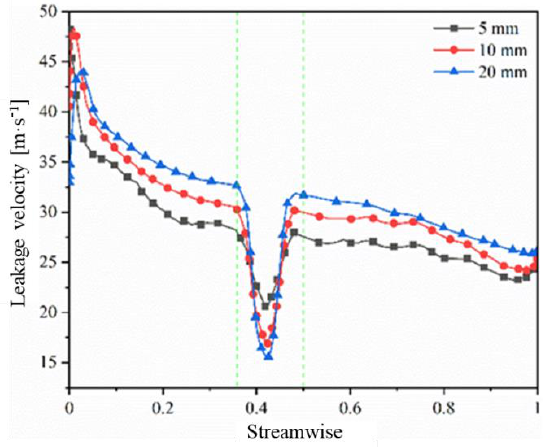
Figure 9. Leakage speed.